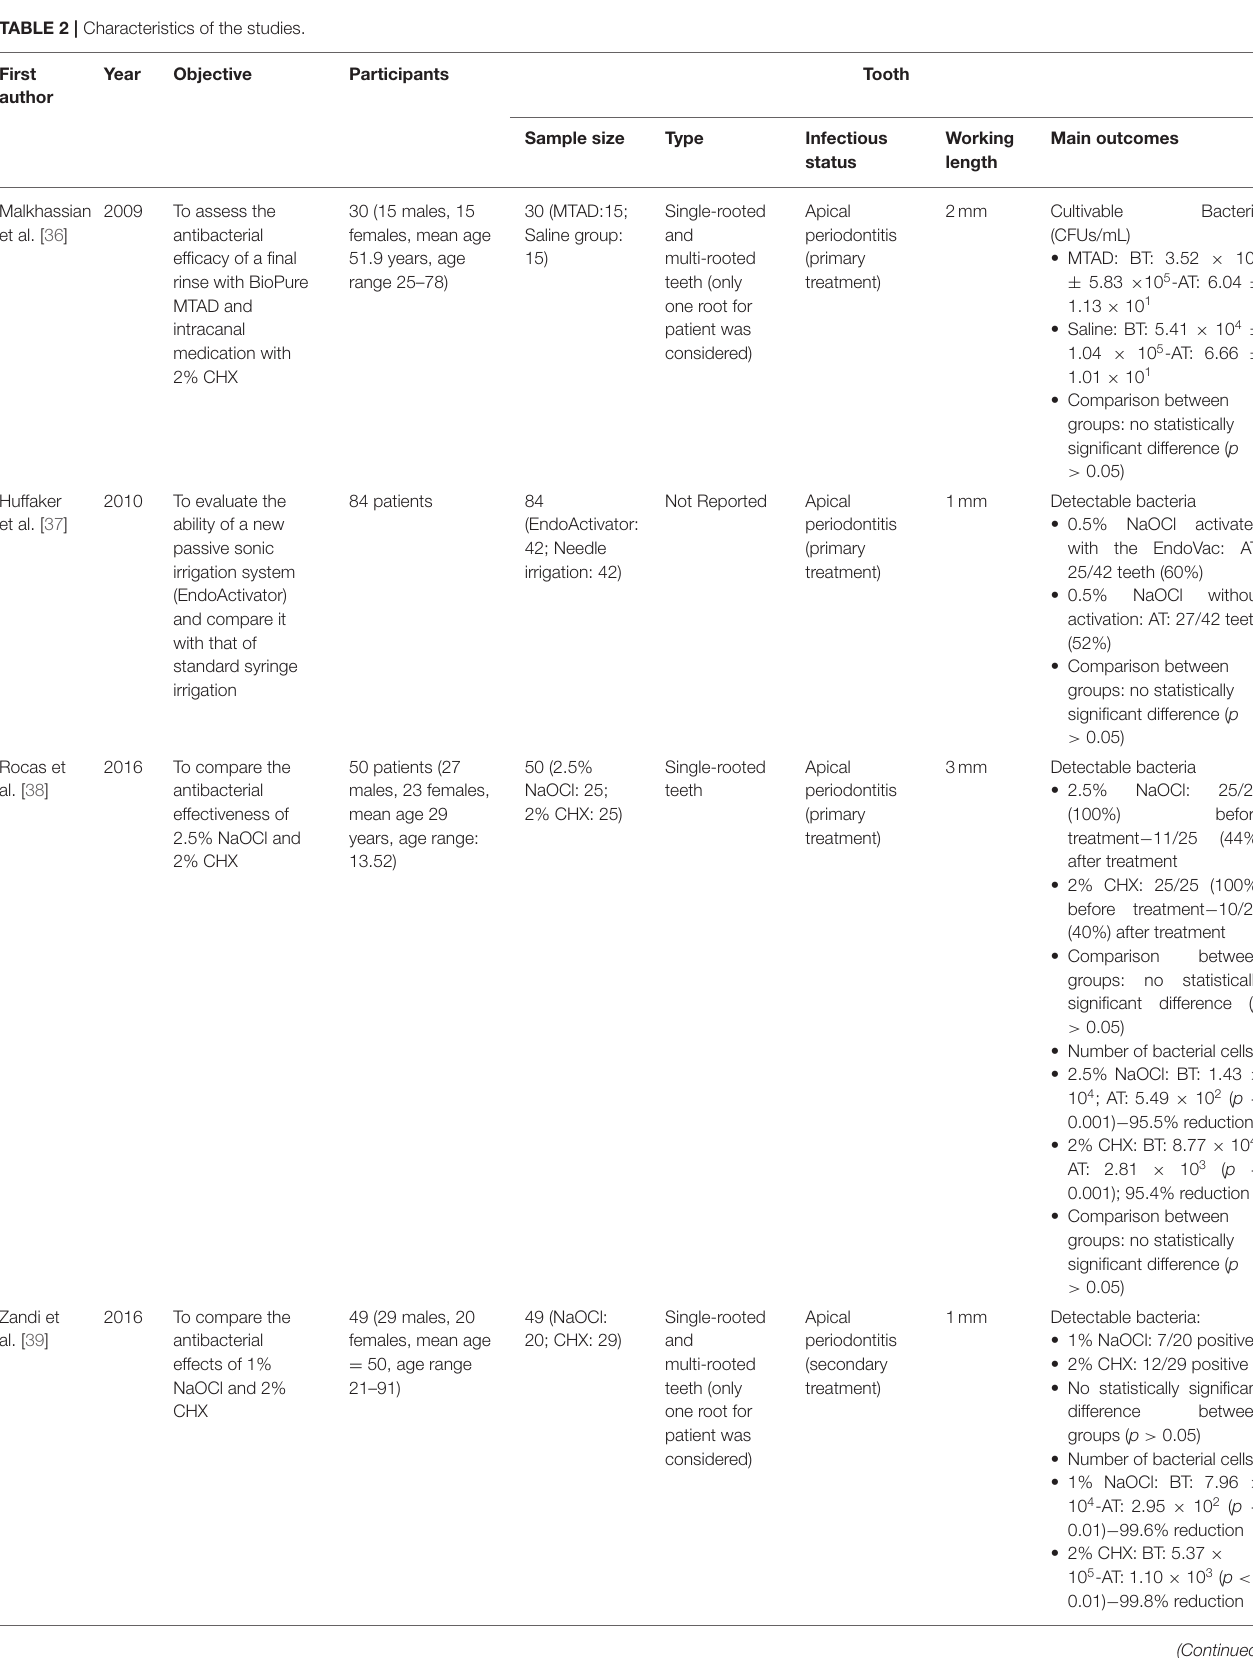
TABLE 2 | Characteristics of the